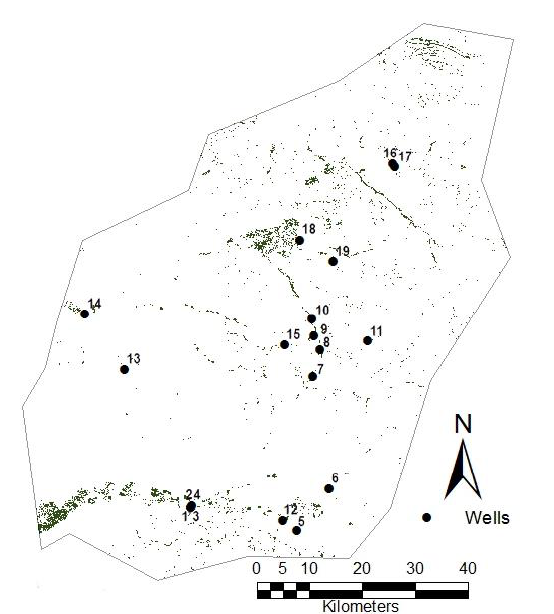
Figure 4. Final image of vegetation area produced by